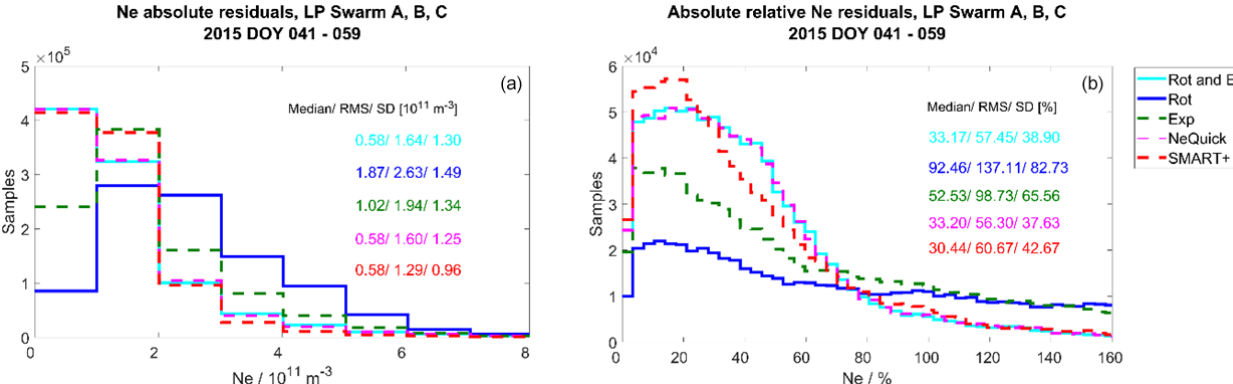
Figure 18. Validation with LP data. Distribution of the Swarm absolute and absolute relative electron density residuals for the quiet